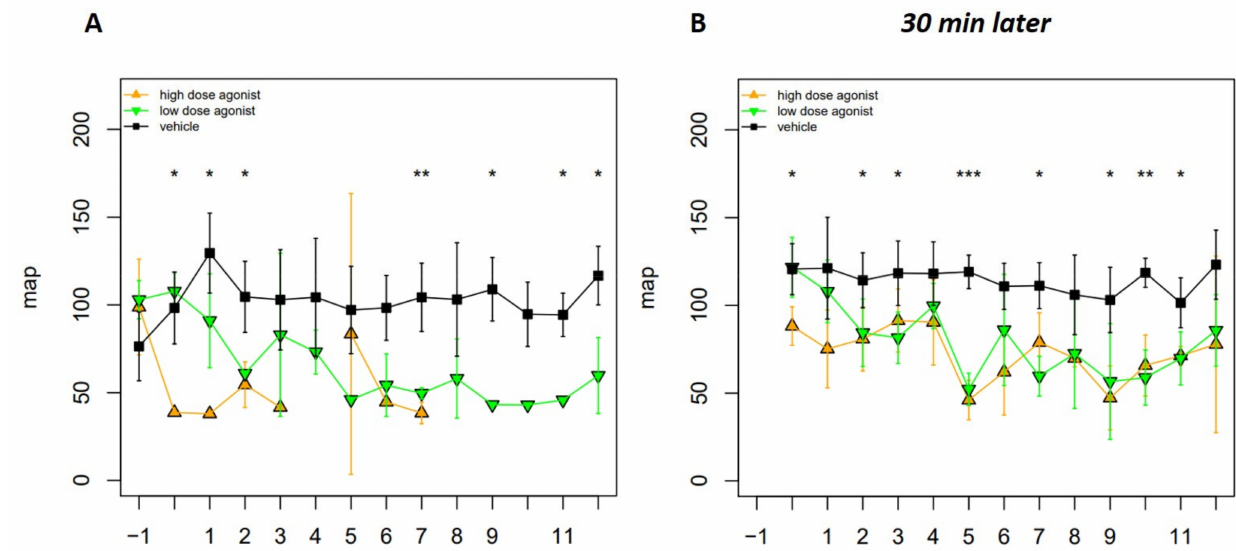
Figure 2. Hypotensive episodes occurred after EP4 receptor agonist administration. Blood pressure was assessed in vehicle- ( n = 4), EP4 receptor high-dose agonist- ( n = 4), and EP4 receptor low-dose agonist- ( n = 4) treated mice after NTS induction. Blood pressure was measured via the tail cuff method immediately ( A ) and 30 min after EP4 agonist injection ( B ) in all three groups. Mean arterial pressure (MAP) is represented as mean ± SEM. Statistical significances are provided compared to vehicle-treated mice (* p ≤ 0.05, ** p ≤ 0.01, *** p ≤